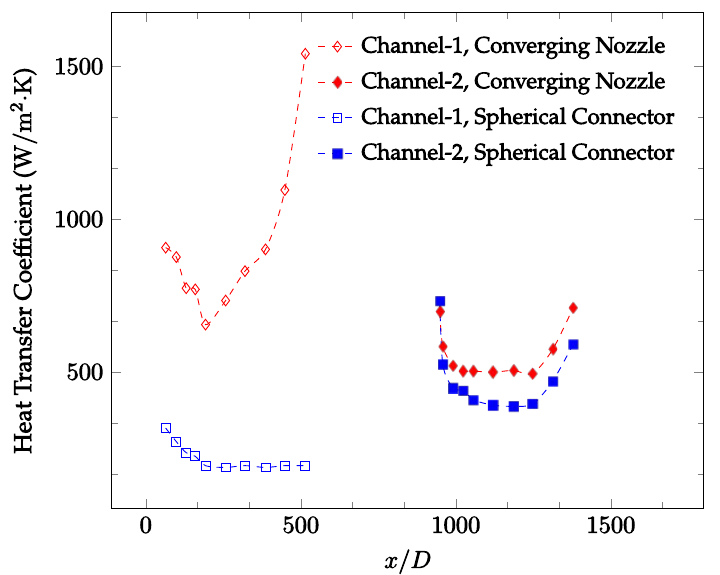
Figure 23. Change in convective heat transfer coefficient of Fe 3 O 4 -deionized water nanofluid as a function of dimensionless distance for a Reynolds number of 100–114. The nanoparticle concentra- tion was 1% by weight. Converging and spherical connectors are